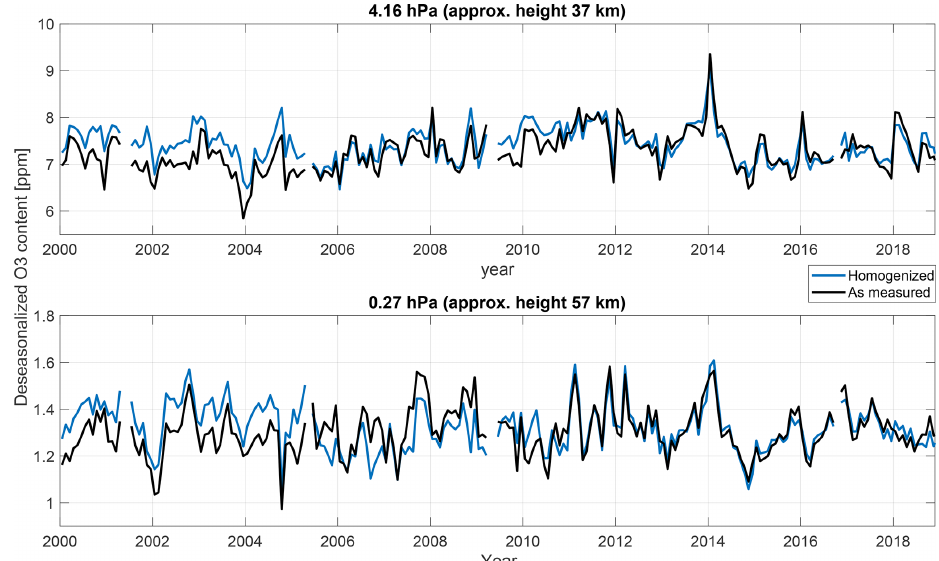
Figure 4. Deseasonalized ozone monthly mean time series before (in black) and after (in blue) the homogenization for a representative layer in the middle stratosphere and in the low